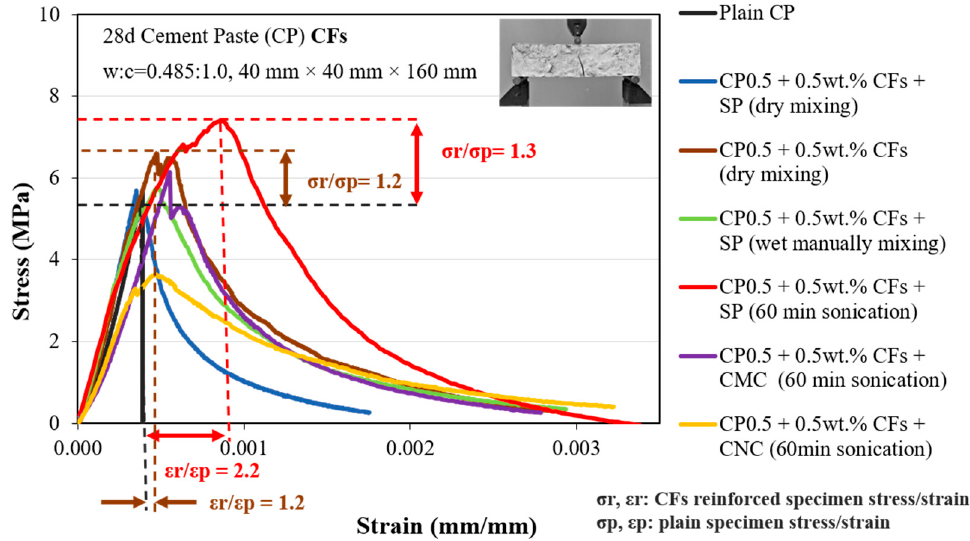
Figure 20. Stress-strain curves of 28-day plain and reinforced with CFs cement pastes at volume fractions of 0.5% from three-point bending tests of 40 mm × 40 mm × 160 mm specimens.